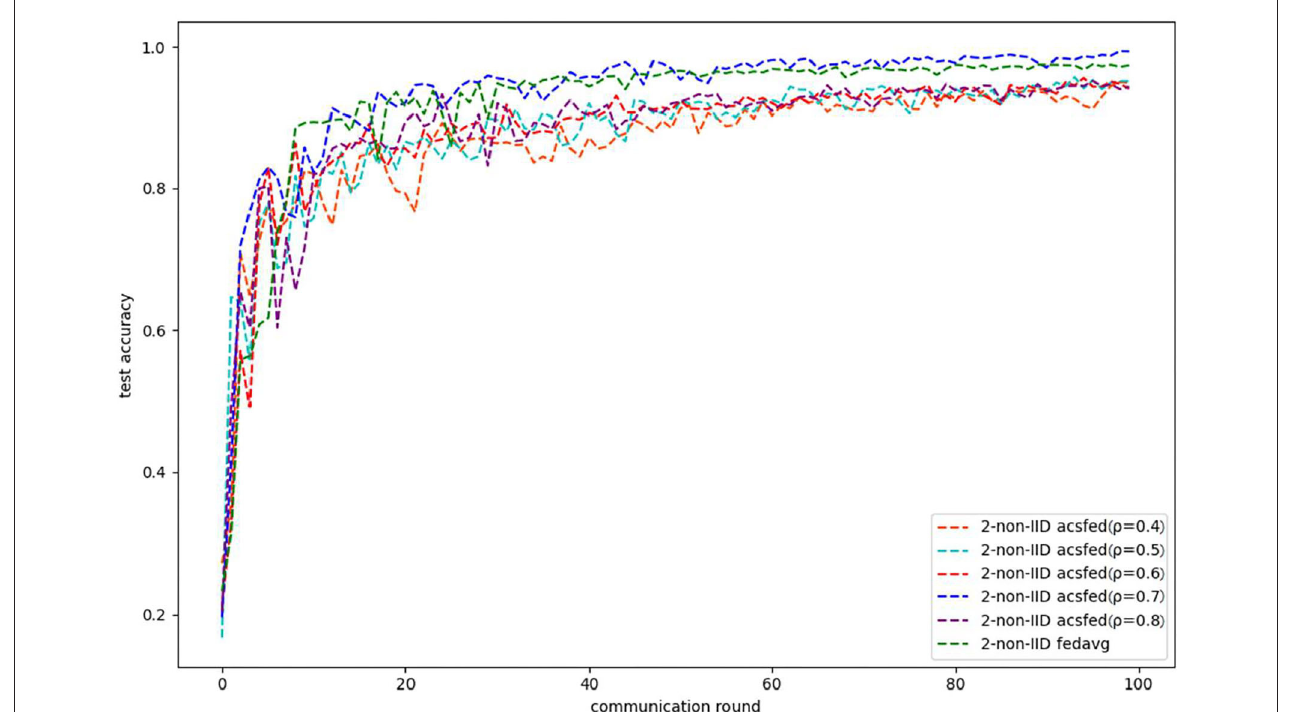
FIGURE 2 | Test accuracy on MNIST in 2-class non-IID scenario.